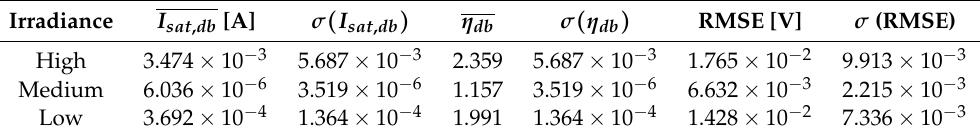
Table 8. Estimated parameters for bypass diode in submodule 2 for high, medium and low irradiances from experimental data and RMSE in the I-V curve reproduction.